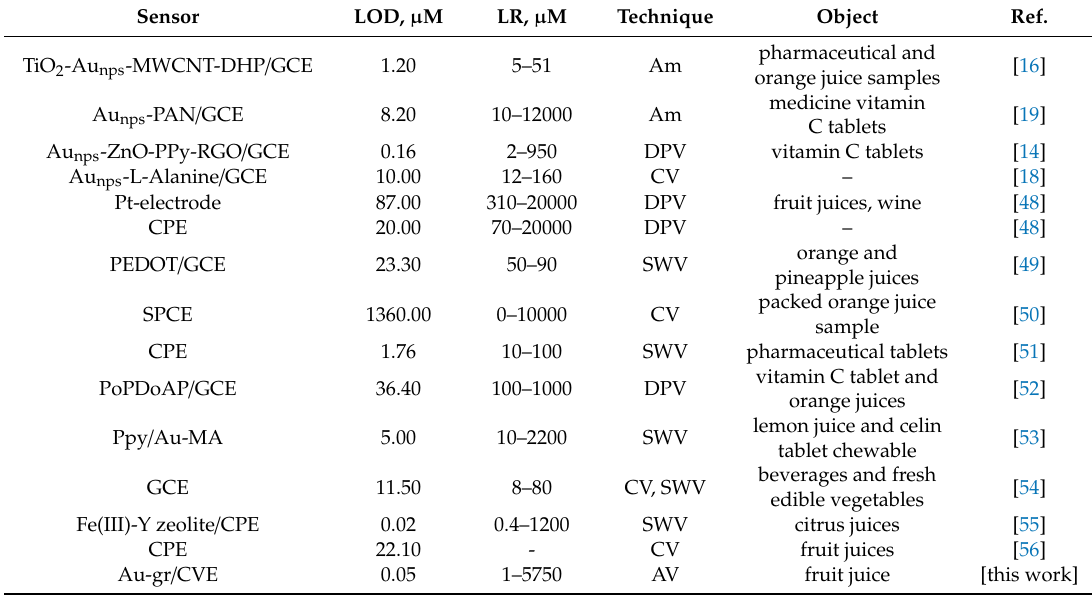
Table 3. Analytical characteristics of AA determination in pharmaceutical tablets, fruit samples, juice and wine on different sensors.